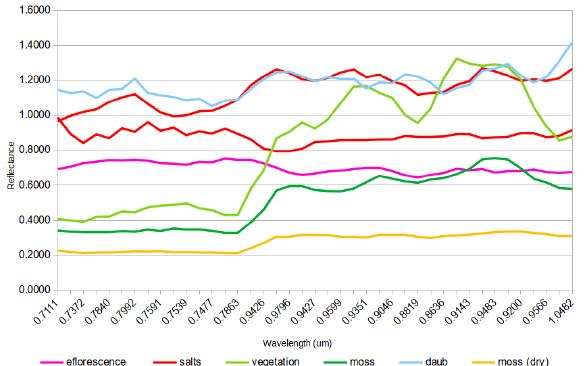
Figure 8 . Spectral signatures derived from the HS images of the St. Nikolas Fort